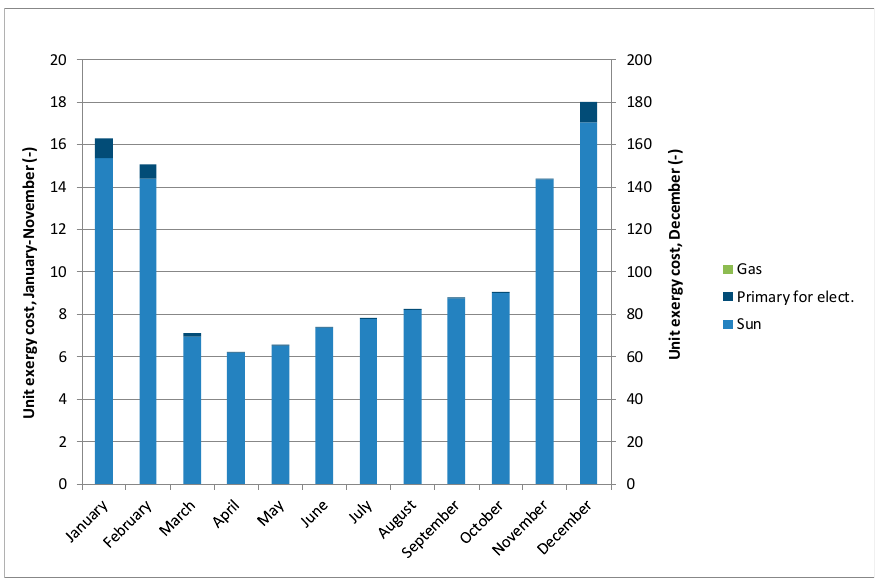
Figure 19. Seasonal storage: Cost formation by irreversibility.